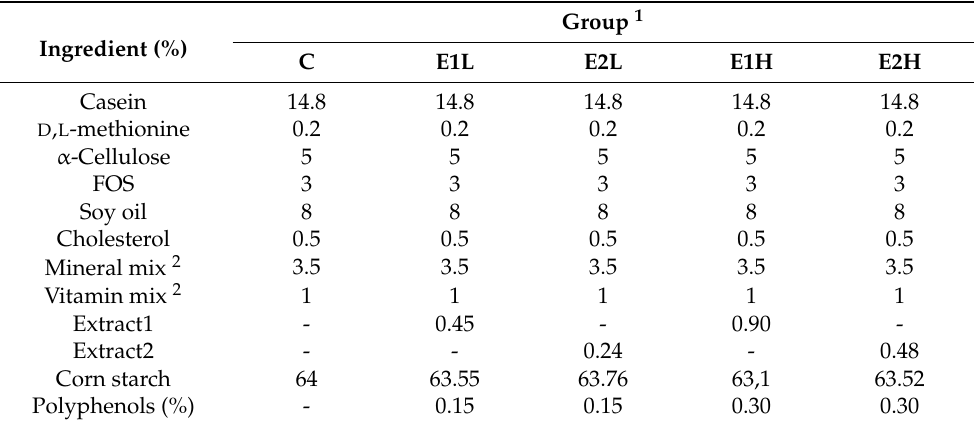
Table A2. Composition of the group-specific